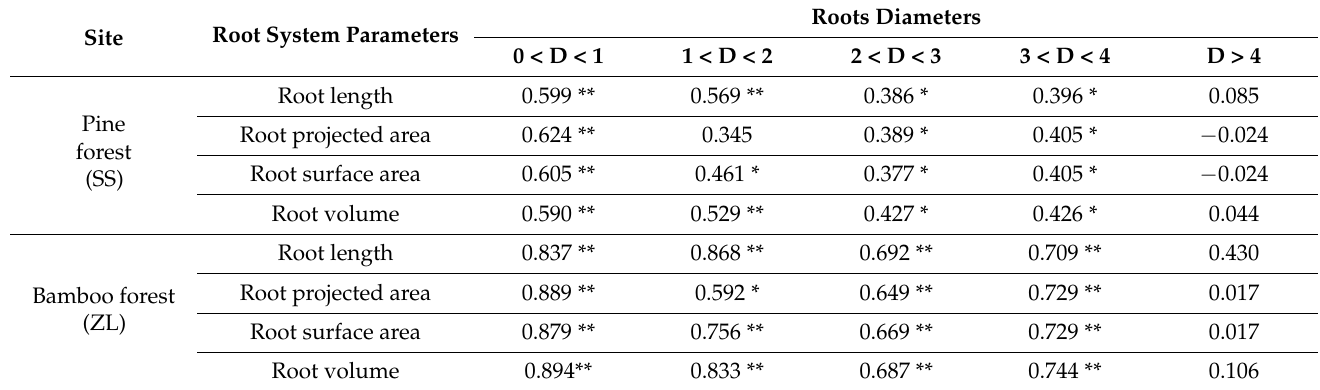
Table 4. Analysis of the correlation between the IHC and root systems with different